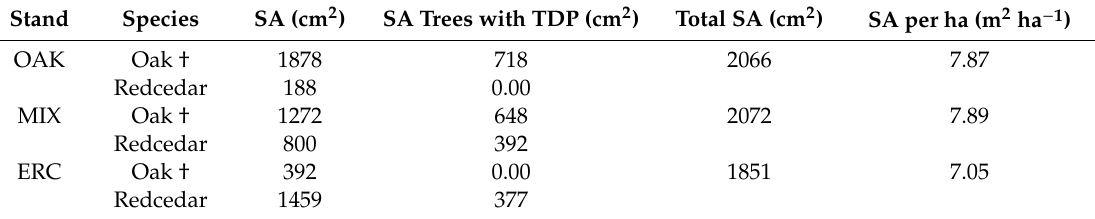
Table 2. Sapwood area (SA) by species, SA of the trees with TPD, total SA, and SA per hectare of each